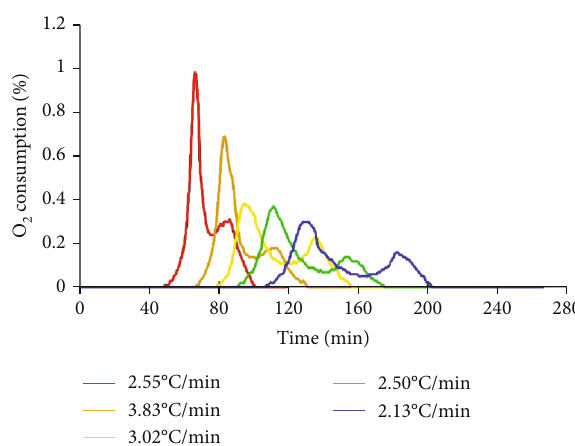
Figure 2: Oxygen consumption for kinetic cell (RTO) experiments with di ff erent heating rates.